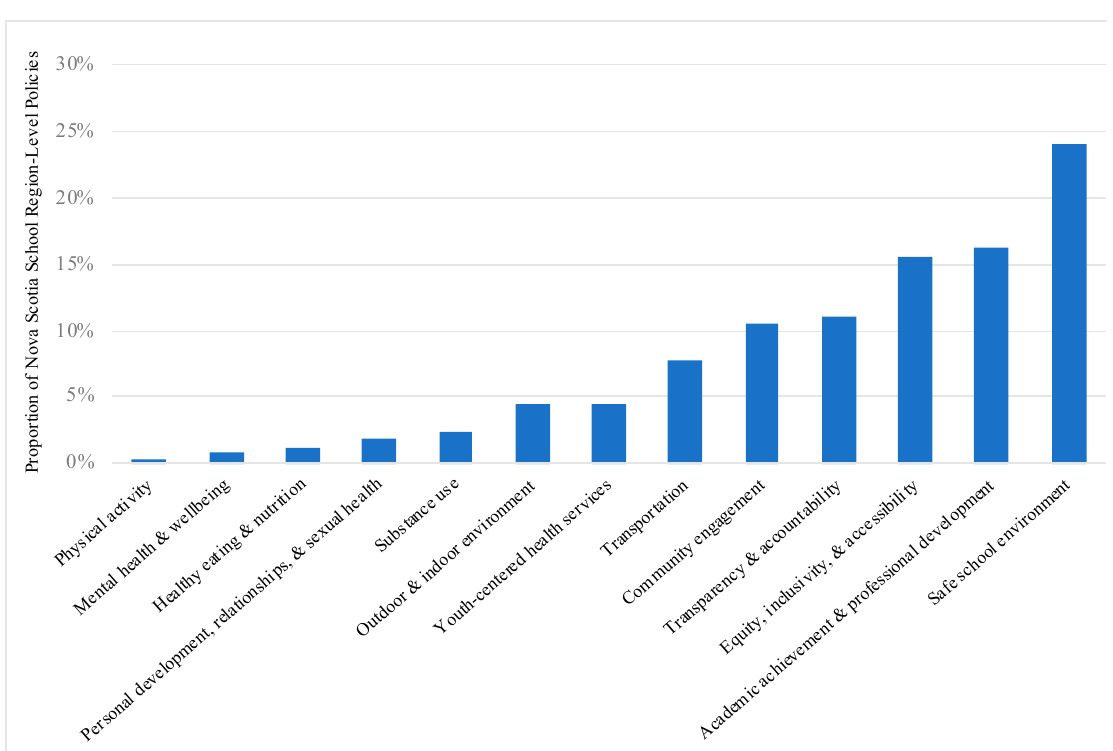
Figure 3. Proportion of Nova Scotia School Region-Level Policies According to Health Promotion Topic Represented. Policies developed across eight Nova Scotia school regions, including the French first-language Conseil Scolaire Acadien Provincial (CSAP), are proportionally represented according to the health promotion topic(s) they were found to align with.